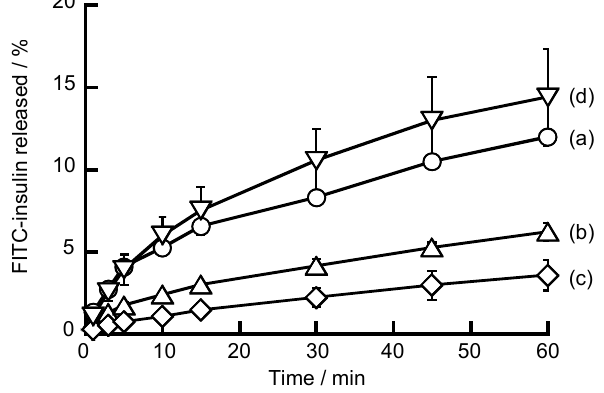
Figure 7. Fluorescein isothiocyanate-labeled insulin (FITC-insulin) release from (NAF/PAH) 5 NAF film in buffer solutions at ( a ) pH 2.0; ( b ) pH 4.0; ( c ) pH 7.4; and ( d ) pH 9.0.